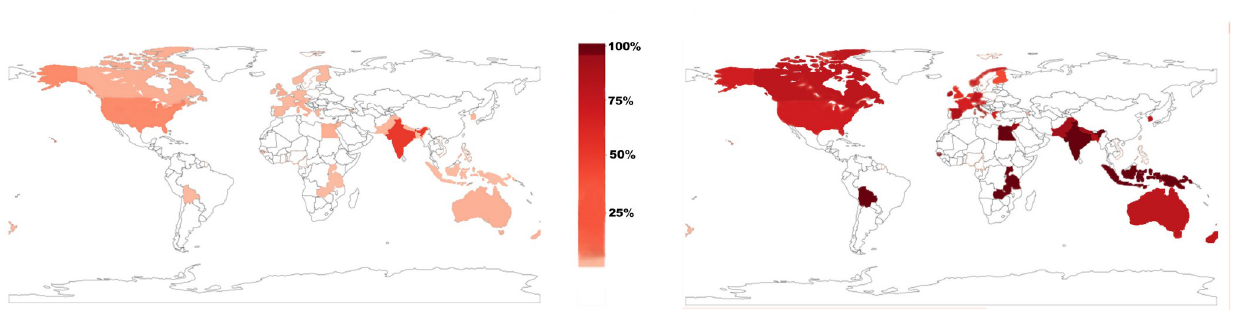
Fig 2. Geographic distribution of included trials. On the left, geographic distribution of trials in our study that reported a consent rate depicted as percent of trials. On the right, geographic distribution of consent rates depicted as median consent rate per country.